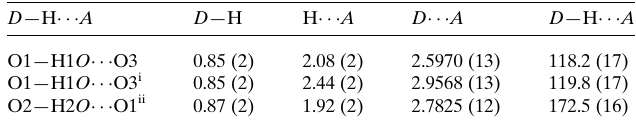
Table 1 Hydrogen-bond geometry (A˚ , (cid:6) ).